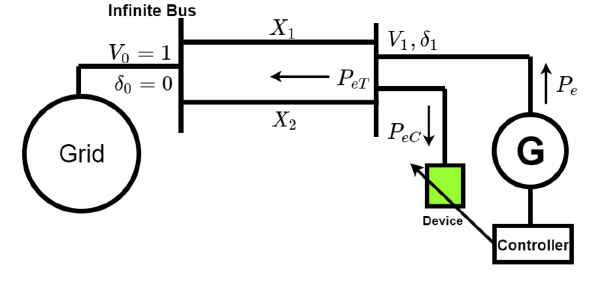
Figure 6. OMIB with power injection/absorption device connected to the generator